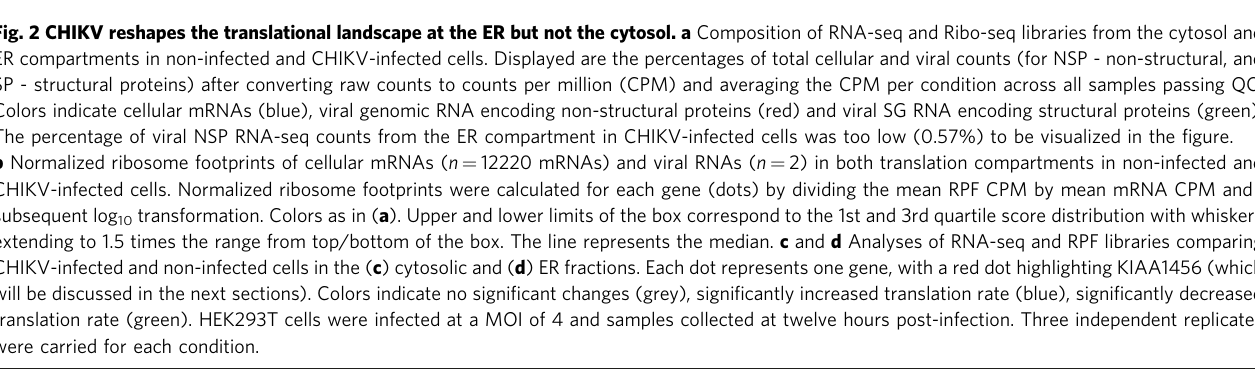
Fig. 2 CHIKV reshapes the translational landscape at the ER but not the cytosol. a Composition of RNA-seq and Ribo-seq libraries from the cytosol and ER compartments in non-infected and CHIKV-infected cells. Displayed are the percentages of total cellular and viral counts (for NSP - non-structural, and SP - structural proteins) after converting raw counts to counts per million (CPM) and averaging the CPM per condition across all samples passing QC. Colors indicate cellular mRNAs (blue), viral genomic RNA encoding non-structural proteins (red) and viral SG RNA encoding structural proteins (green). The percentage of viral NSP RNA-seq counts from the ER compartment in CHIKV-infected cells was too low (0.57%) to be visualized in the fi gure. b Normalized ribosome footprints of cellular mRNAs ( n = 12220 mRNAs) and viral RNAs ( n = 2) in both translation compartments in non-infected and CHIKV-infected cells. Normalized ribosome footprints were calculated for each gene (dots) by dividing the mean RPF CPM by mean mRNA CPM and subsequent log 10 transformation. Colors as in ( a ). Upper and lower limits of the box correspond to the 1st and 3rd quartile score distribution with whiskers extending to 1.5 times the range from top/bottom of the box. The line represents the median. c and d Analyses of RNA-seq and RPF libraries comparing CHIKV-infected and non-infected cells in the ( c ) cytosolic and ( d ) ER fractions. Each dot represents one gene, with a red dot highlighting KIAA1456 (which will be discussed in the next sections). Colors indicate no signi fi cant changes (grey), signi fi cantly increased translation rate (blue), signi fi cantly decreased translation rate (green). HEK293T cells were infected at a MOI of 4 and samples collected at twelve hours post-infection. Three independent replicates were carried for each